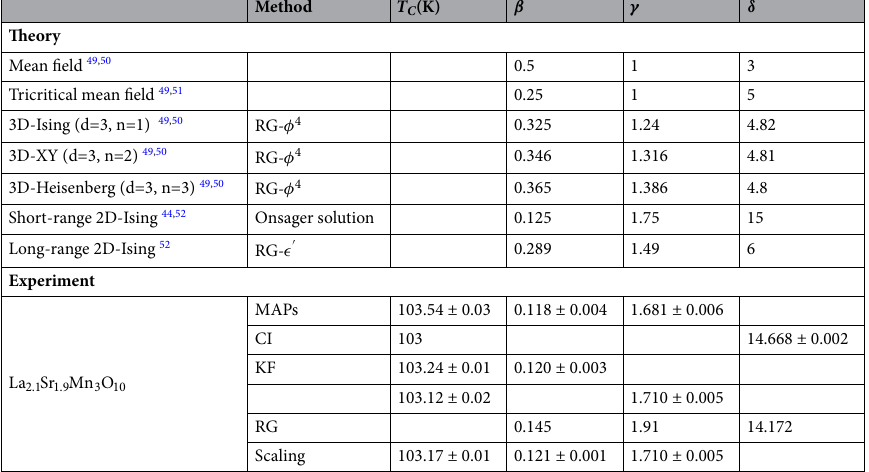
Table 2. Comparison of critical exponents β , γ and δ of TL-LSMO-0.3 with various theoretical models for three dimension and two dimension. RG: Renormalization group, CI: Critical isotherm.